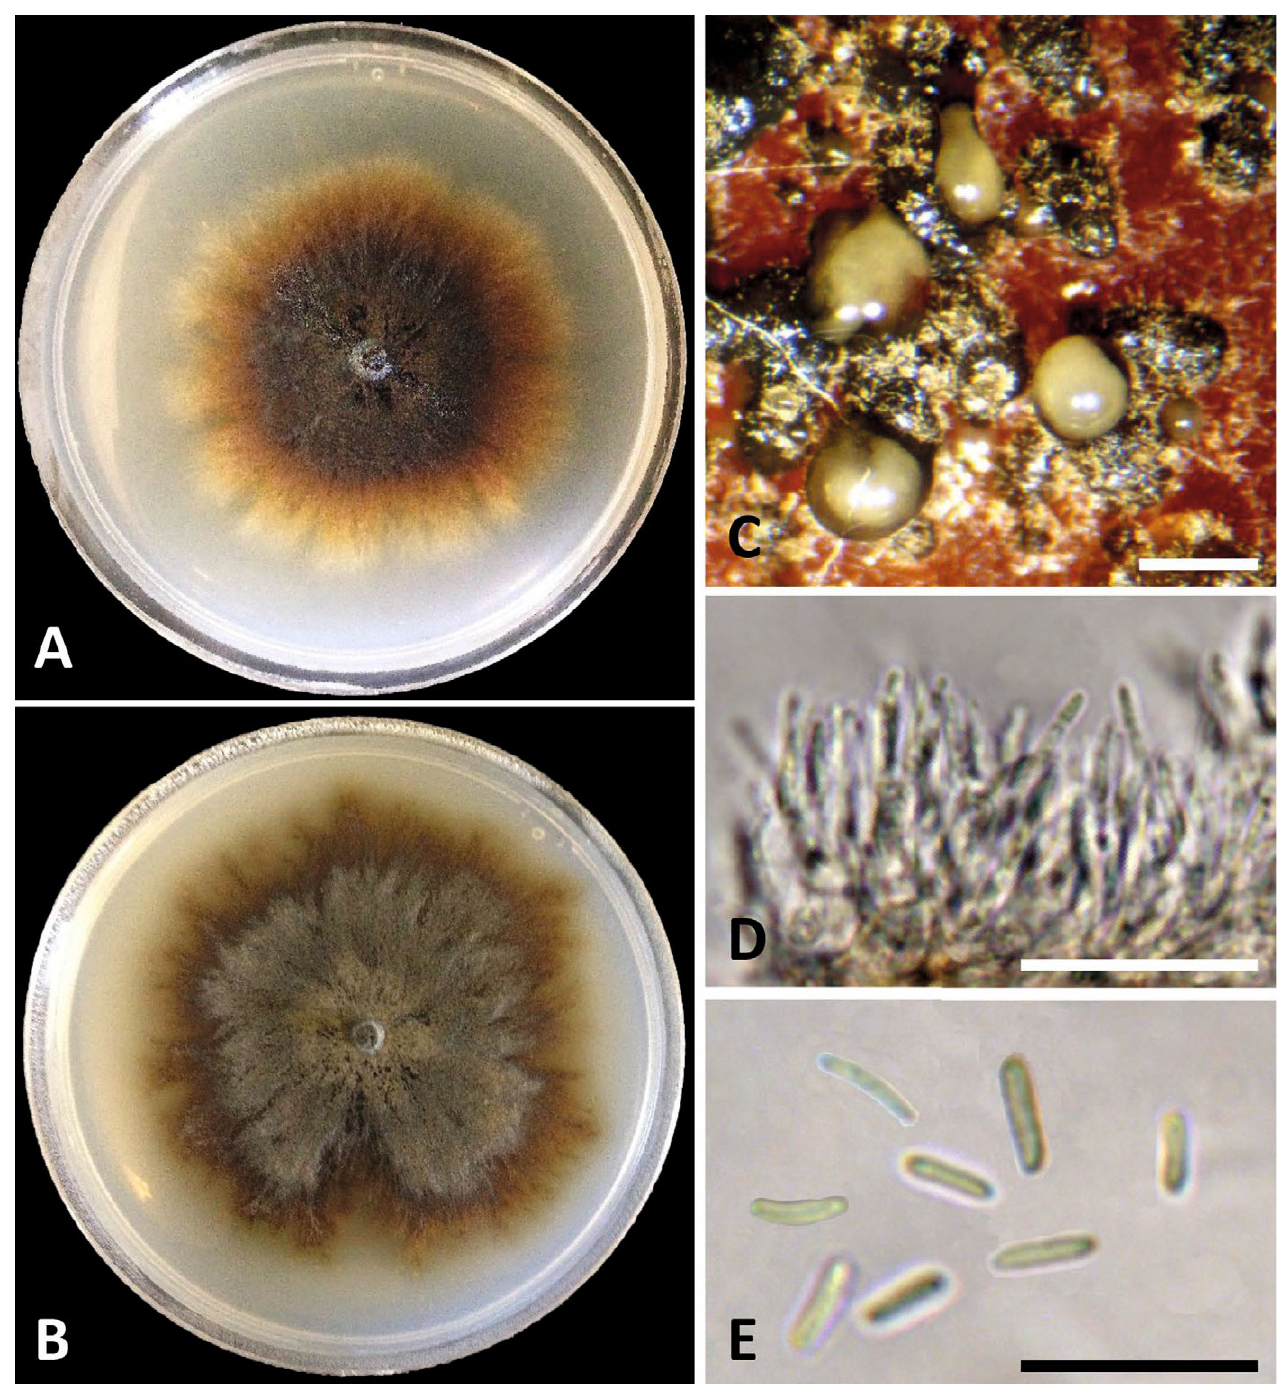
Fig. 18. Cytospora punicae (CBS 144244). A. Seven-day-old PDA culture. B. Fourteen-day-old PDA culture. C. Pycnidia. D. Conidiophores